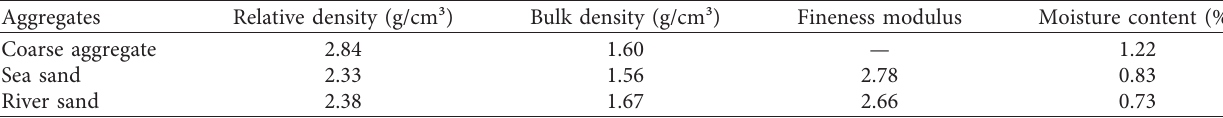
Figure 1: Particle size distributions of (a) coarse aggregate and (b) sea sand and river sand. Table 1: Physical properties of aggregates used in this study.